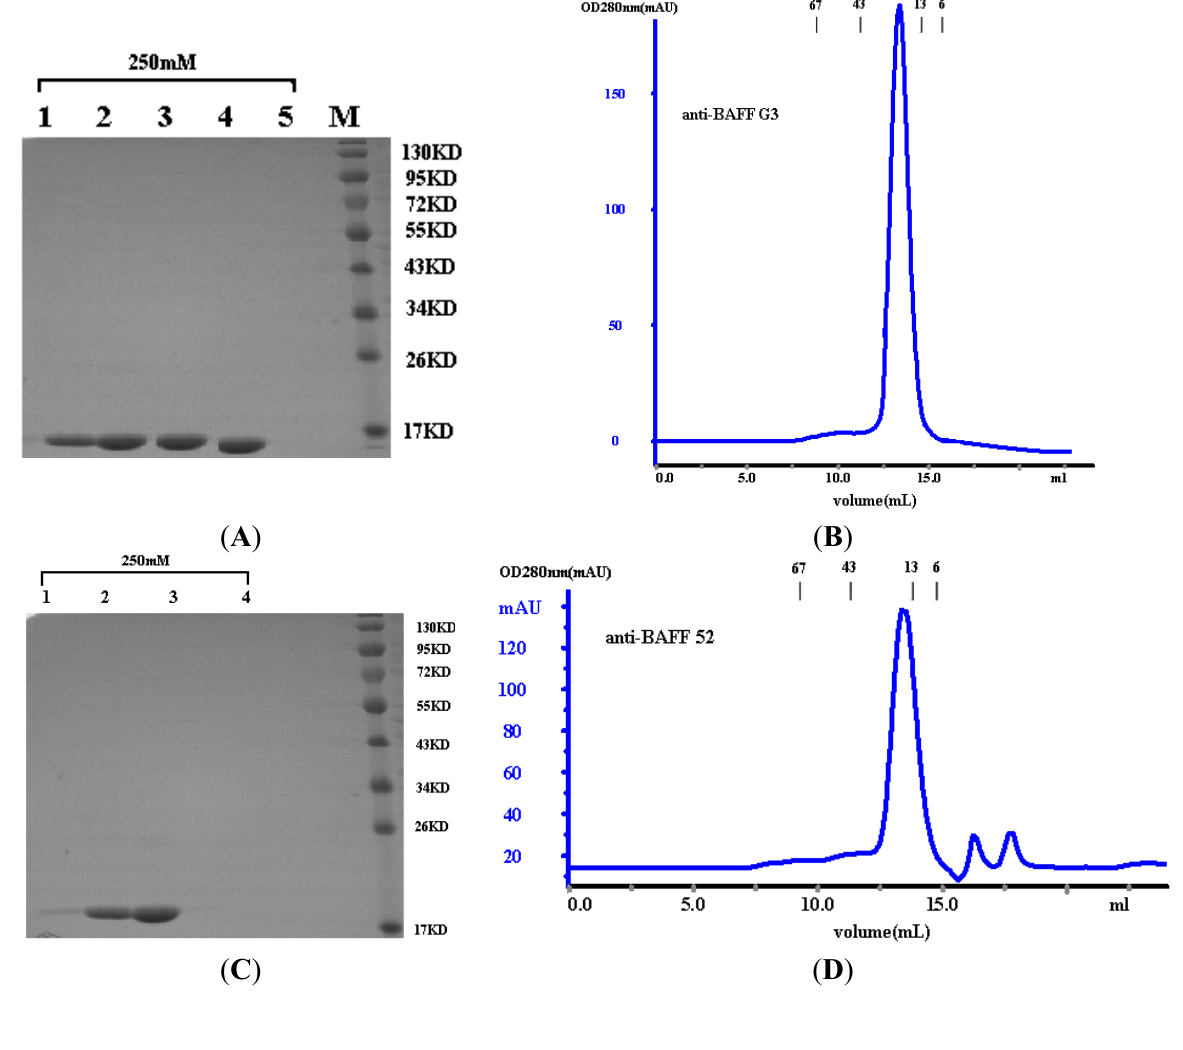
Figure 2. Sodium dodecyl sulfate-polyacrylamide gel electrophoresis (SDS-PAGE) and size exclusion chromatography of VHHs. BAFF, B cell-activating factor. ( A ) SDS-PAGE analysis of expression and purification anti-BAFFG3. Lane M: Molecular weight protein marker; Lane 1–5: The purified products collected from different test tubes in the same batch; ( B ) Purified anti-BAFFG3 protein was analyzed by size exclusion chromatography with a Superdex 75 column; ( C ) SDS-PAGE analysis of expression and purification anti-BAFF52. Lane M: Molecular weight protein marker; Lane 1–4: The purified products collected from different test tubes in the same batch; ( D ) Purified anti-BAFF52 protein was analyzed by size exclusion chromatography with a Superdex 75 column; ( E ) SDS-PAGE analysis of expression and purification anti-BAFF64. Lane M: Molecular weight protein marker; Lane 1–4: The purified products collected from different test tubes in the same batch; Lane 5: Total cells of TG1 with pSJF2- VHH induced by 1 mM isopropyl β - D -thiogalactopyranoside (IPTG) for 4 h before purified; ( F ) Purified anti-BAFF64 protein was analyzed by size exclusion chromatography with a Superdex 75